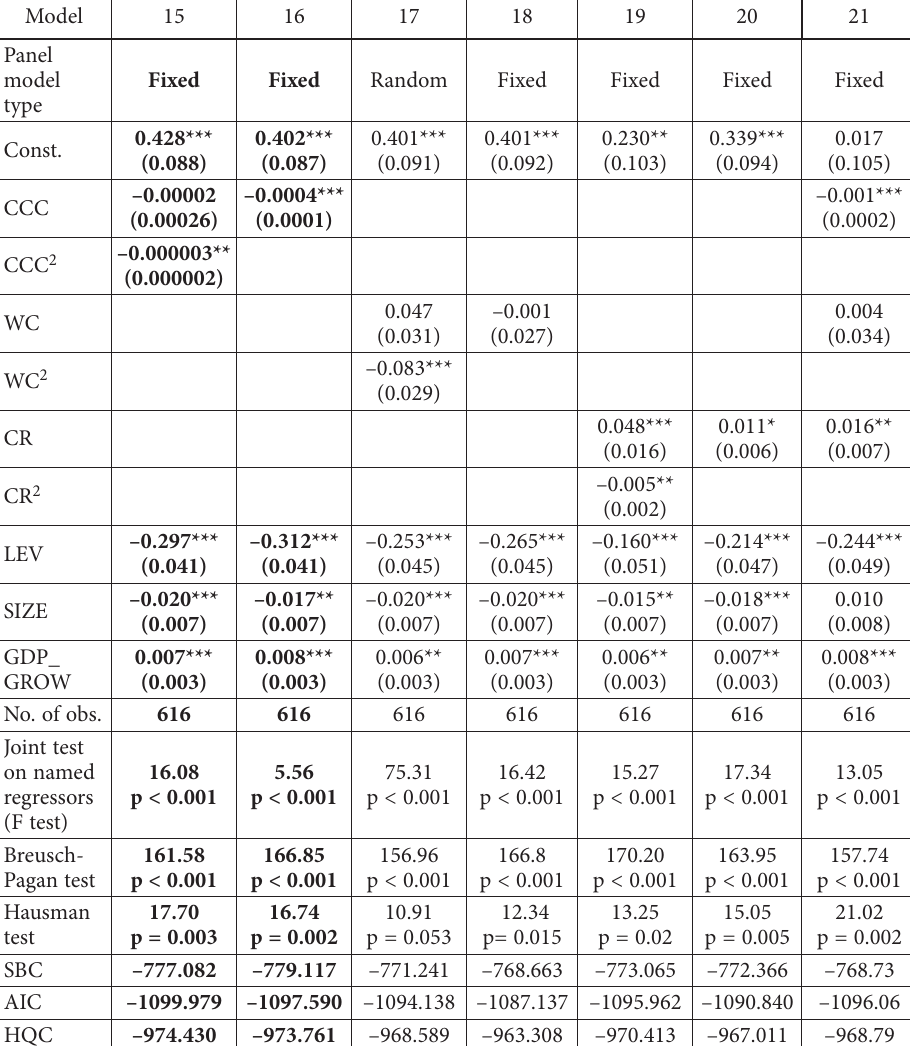
Table 9. Results of model estimation (“Technology, media & telecoms” industry) (source: own elabora-